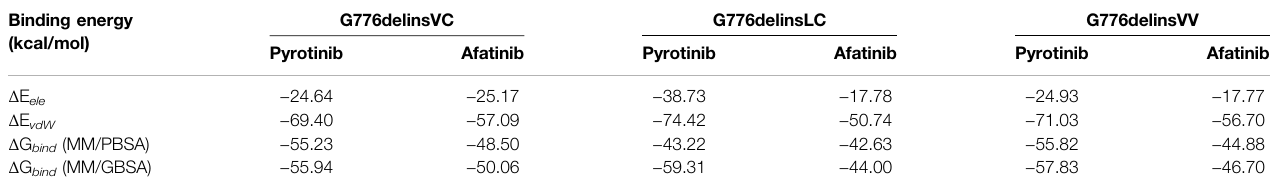
TABLE 2 | Binding energy of HER2 -targeted inhibitor afatinib and pyrotinib for Gly776 deletion-insertion variants. Binding energy (kcal/mol)